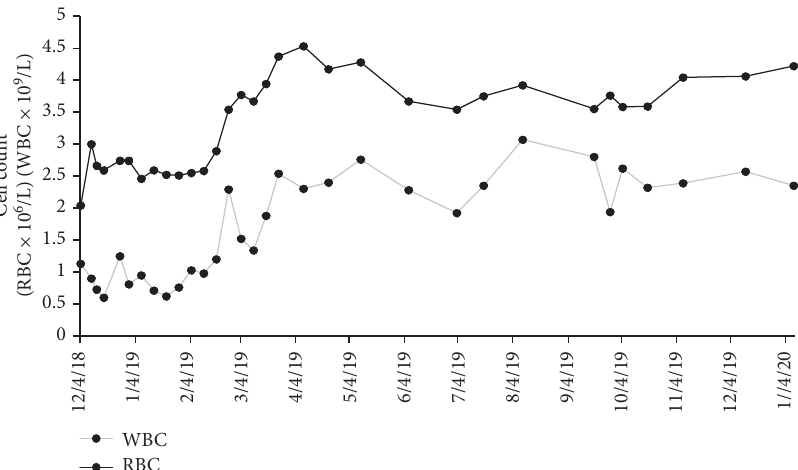
Figure 1: Red blood cell and white blood cell count recorded during Venetoclax monotherapy treatment from December 2018 to January 2020. The treatment initially began on November 28, 2018 at 100mg and after one month was increased to 200mg.